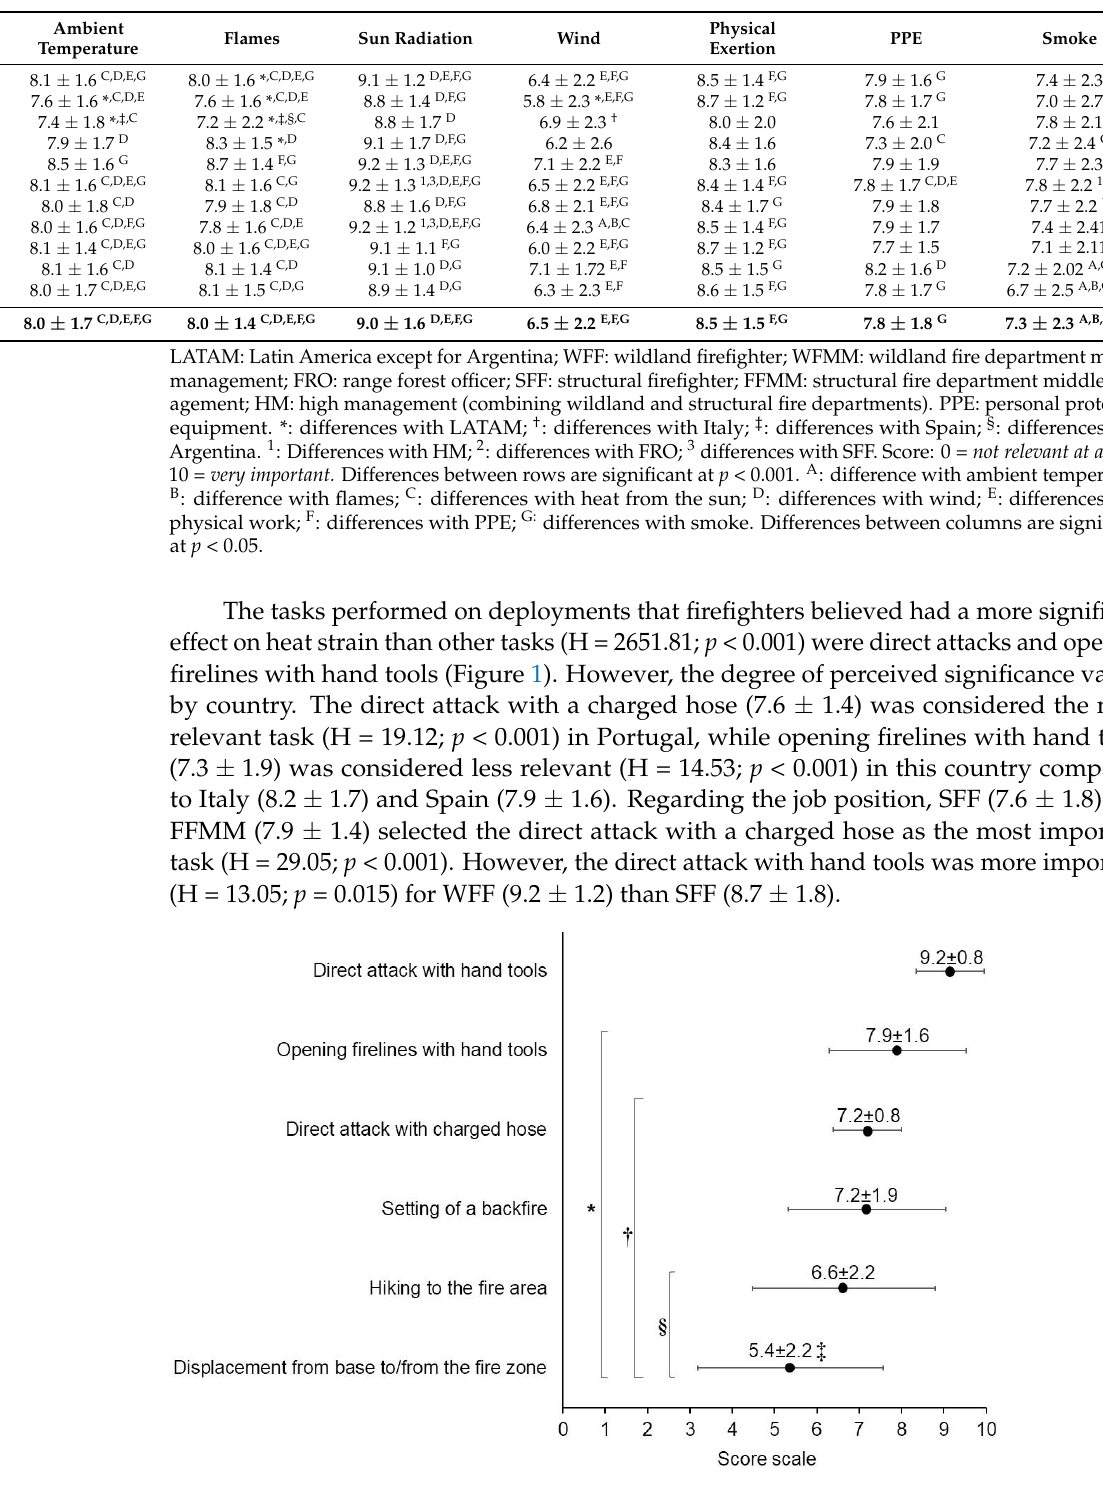
Figure 1. Overall perceived importance of tasks performed in wildland fire suppression in relation to heat stress (mean ± SD). Score: 0 = not relevant at all and 10 = very important . *: differences with direct attack with hand tools; † : differences with opening firelines with hand tools; § : differences with charged hose and backfire; ‡ : differences between hiking to the fire area and displacement from base to/from the fire zone. All differences are significant at p < 0.001. Finally, respondents considered low physical fitness (9.0 ± 1.8), overweight (8.7 ± 1.8), hydration level, poor diet (8.6 ± 1.9) and alcohol consumption (8.2 ± 2.2) as factors that